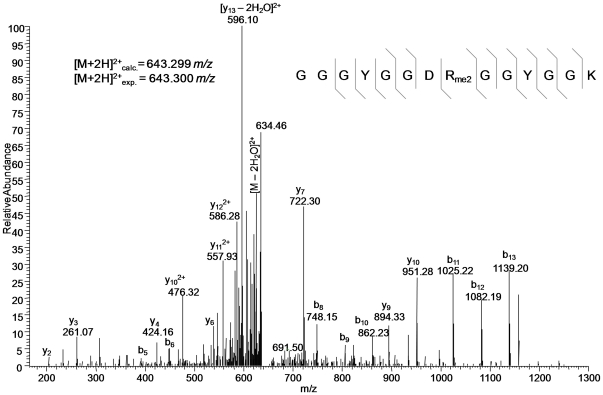
Post-translational modification of a chromatin-associated protein.MS/MS spectrum of the [M+2H]2+ precursor ion of TAF 2N isoform 2 (473–487 residue peptide) dimethylated on R480. Broken bonds above and below sequence denote b and y ions, respectively, that were annotated from the spectrum.